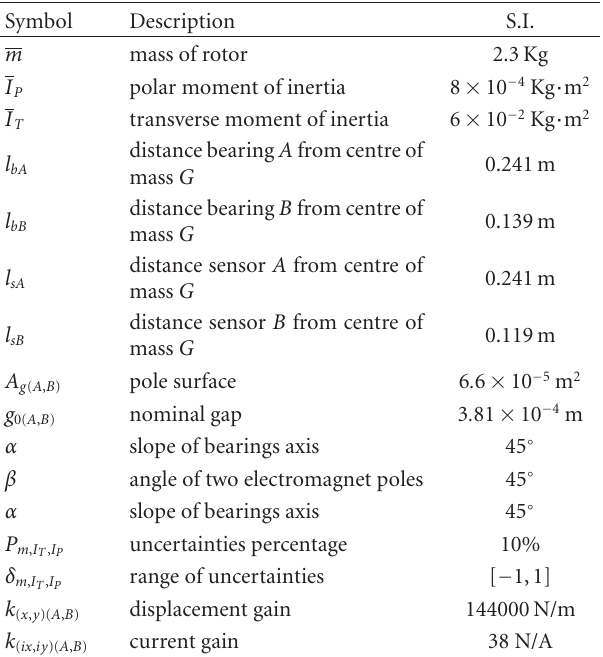
Table 1: Data for